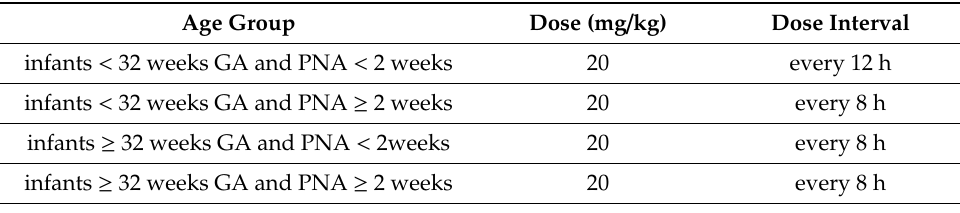
Table 1. Recommended meropenem IV dosage schedule for pediatric patients less than 3 months of age with complicated intra-abdominal infections and normal renal function (GA: gestational age (at birth), weeks and PNA, postnatal age, days)